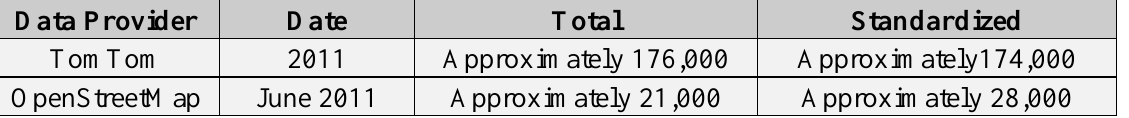
Table 2. Total Number of TomTom and OSM Turn Restrictions in Germany (June 2011).